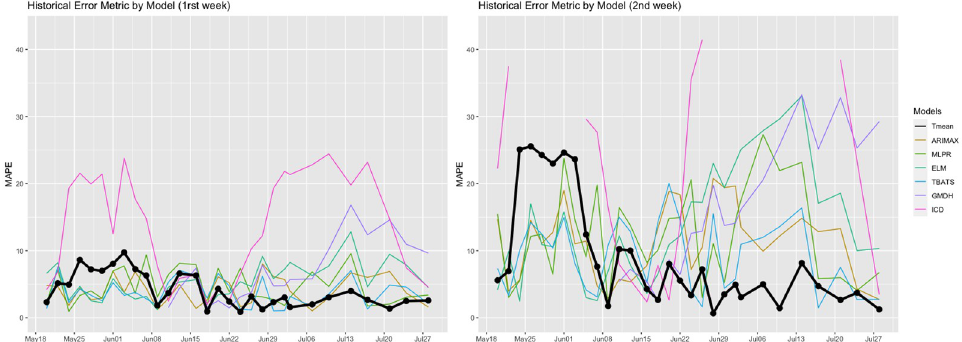
Fig 5. MAPEs across time for each